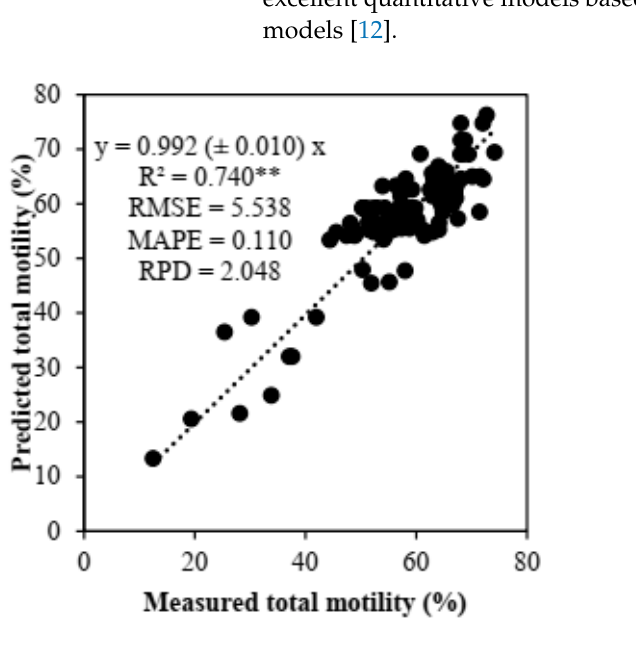
Table 4. Correlations between components and total motility (TM), progressive motility (PM), and the sensitivity analyses using the Monte Carlo simulation.